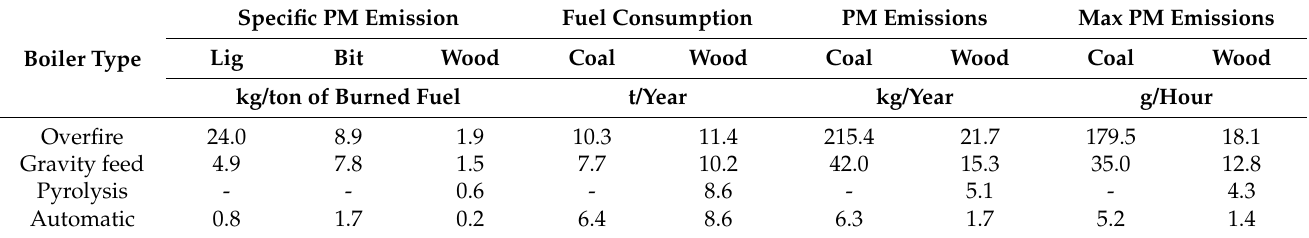
Table 2. Particulate emissions per household according to the type of